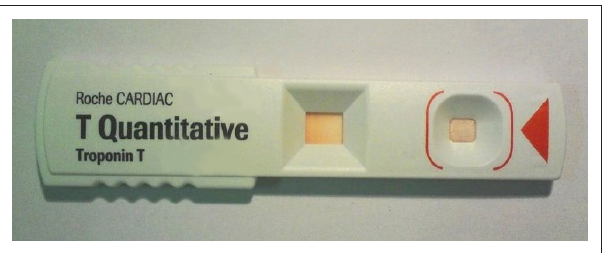
FIGURE 1: Absence of a control line on the Roche CARDIAC Troponin T Quantitative test strip. TABLE 1: CARDIAC Troponin T Quantitative test strip performance. Sample